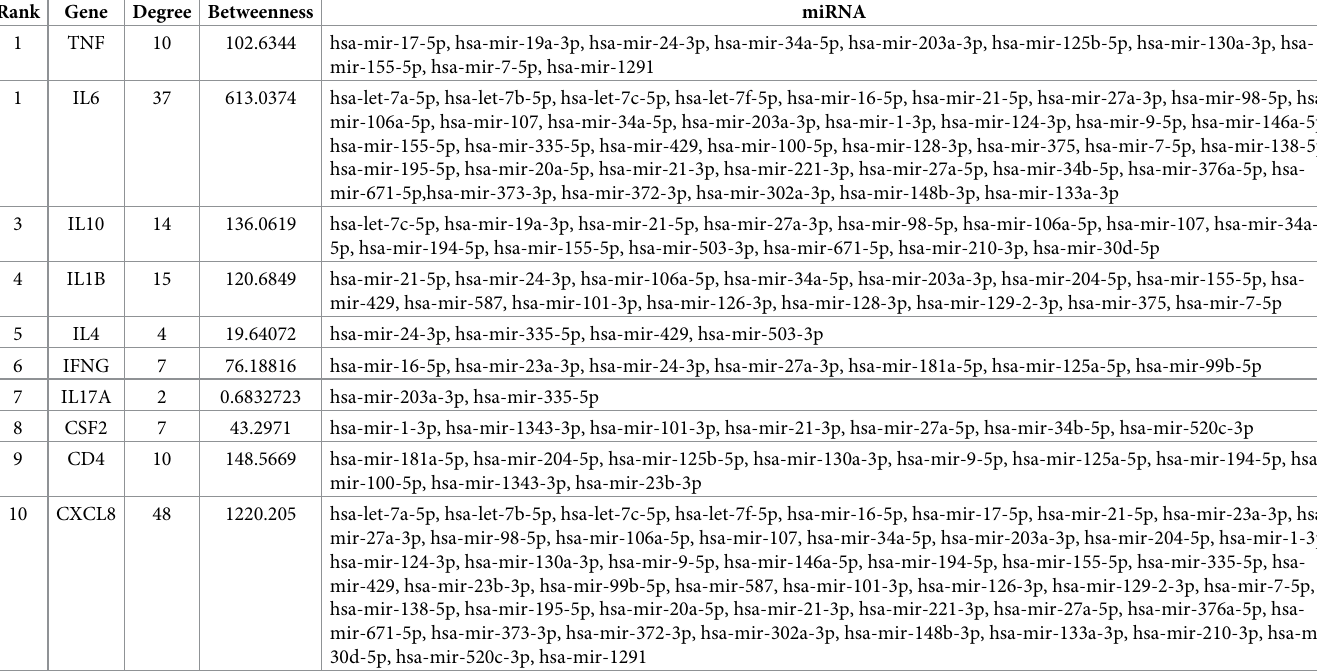
Table 3. miRNAs of each hub genes given with the degree and the betweenness obtained from the miRNet tool. Rank Gene Degree Betweenness